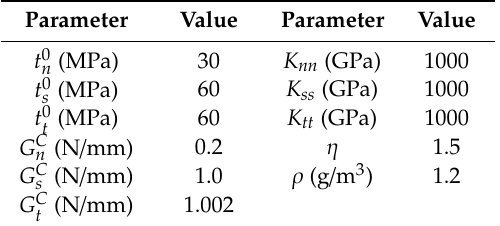
Table 5. Material parameters of composite adhesive interface layer [13].